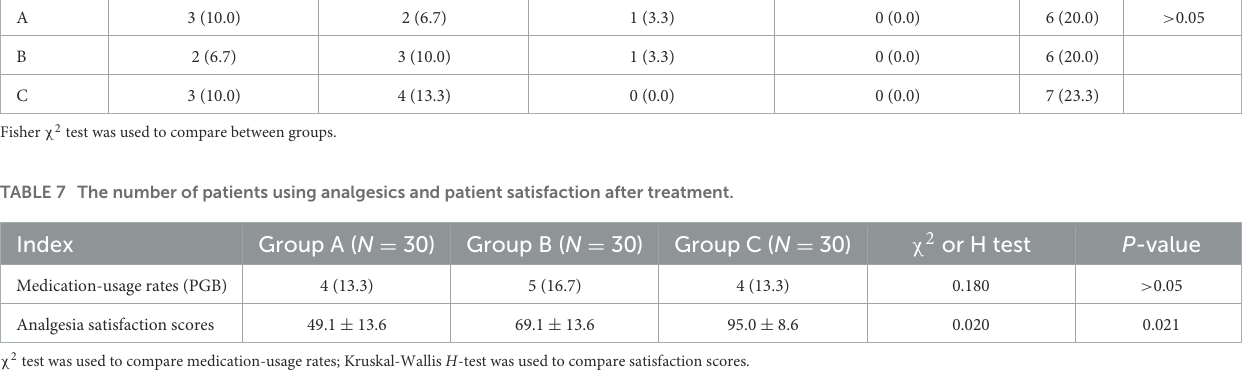
TABLE 6 Comparison of treatment-related adverse events 1 month after treatment [ n (%)]. Groups